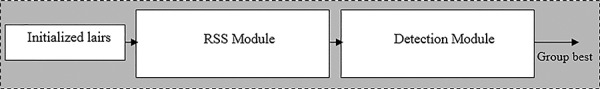
Configuration of the RSS system.